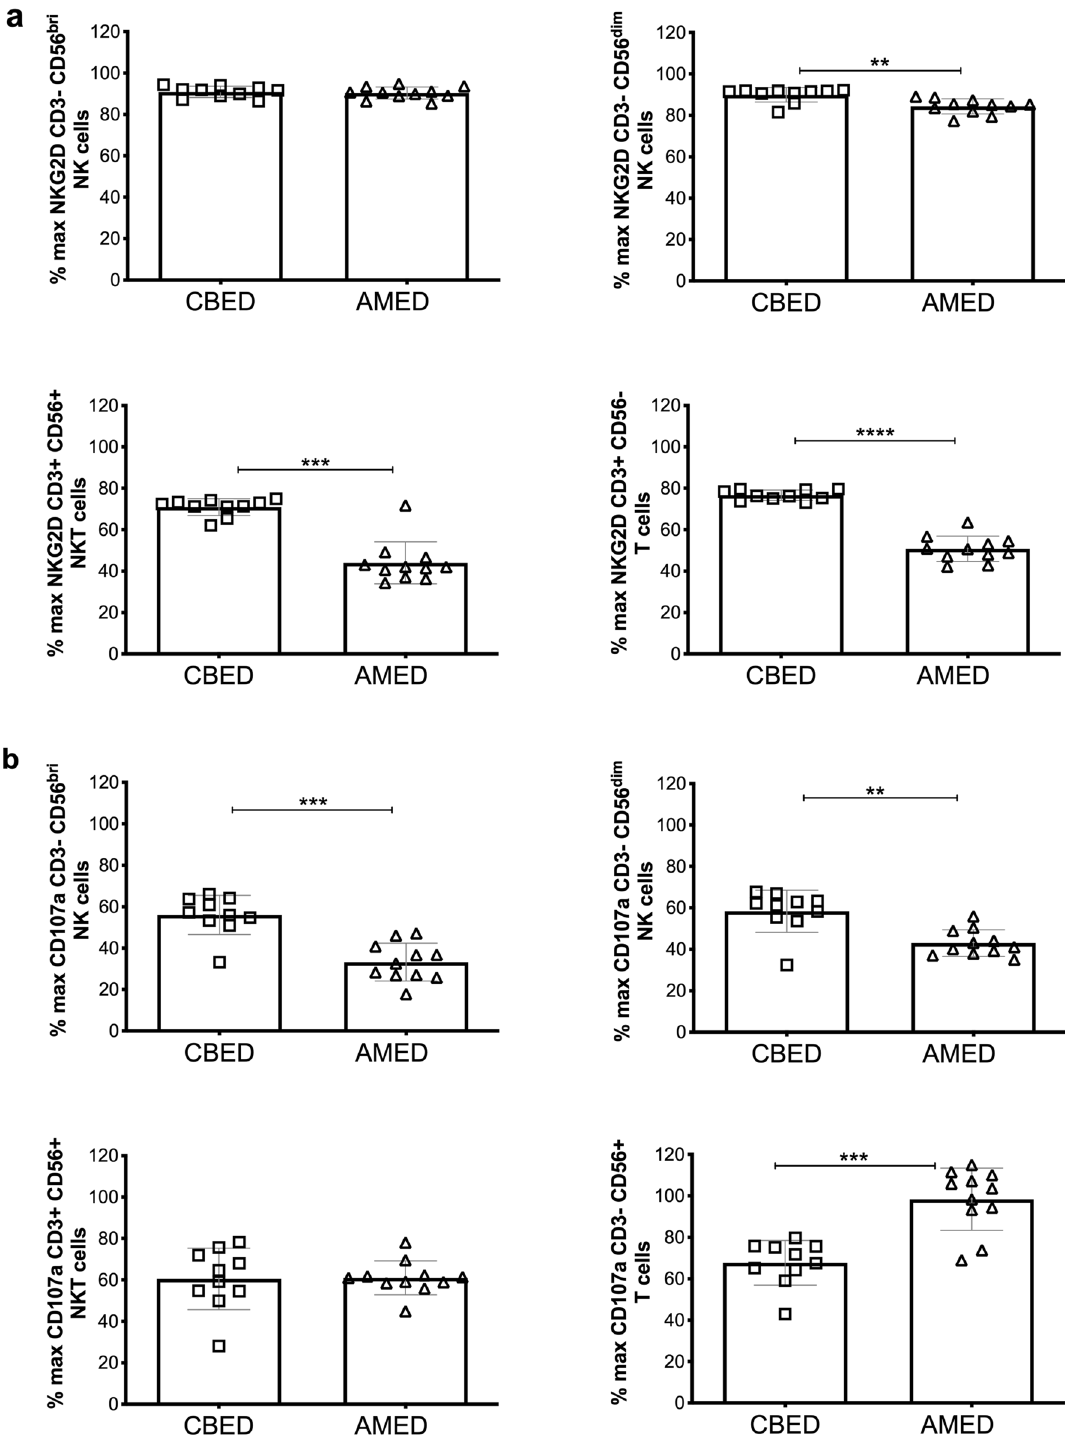
Figure 4. Expression of NKG2D and CD107a on NK, NKT and T cells from healthy donors is reduced by incubation with either CBED or AMED preparations. Results show percentage of maximum expression relative to complete media in CD3 − CD56 dim , CD3 − CD56 bright NK cells, CD3 + CD56 + NKT cells and CD3 + CD56 - T cells from adult donor PBMCs after incubation with either eye drop preparation followed by PMA and ionomycin stimulation. ( a ) NKG2D ( b ) CD107a. Eye drop preparations investigated were CBED (n = 10) and AMED (n = 10). PBMCs were incubated with 50% eye drop solution (diluted with complete media and IL-2) or complete media and IL-2 only for 48 h prior to antibody staining and flow cytometry analysis. Each experiment was repeated with four different PBMC donors and data points represent donor means. Statistical analysis was performed using nonparametric Mann–Whitney test. p < 0.01 ( ** ); p < 0.001 ( *** ), p < 0.0001 ( ****